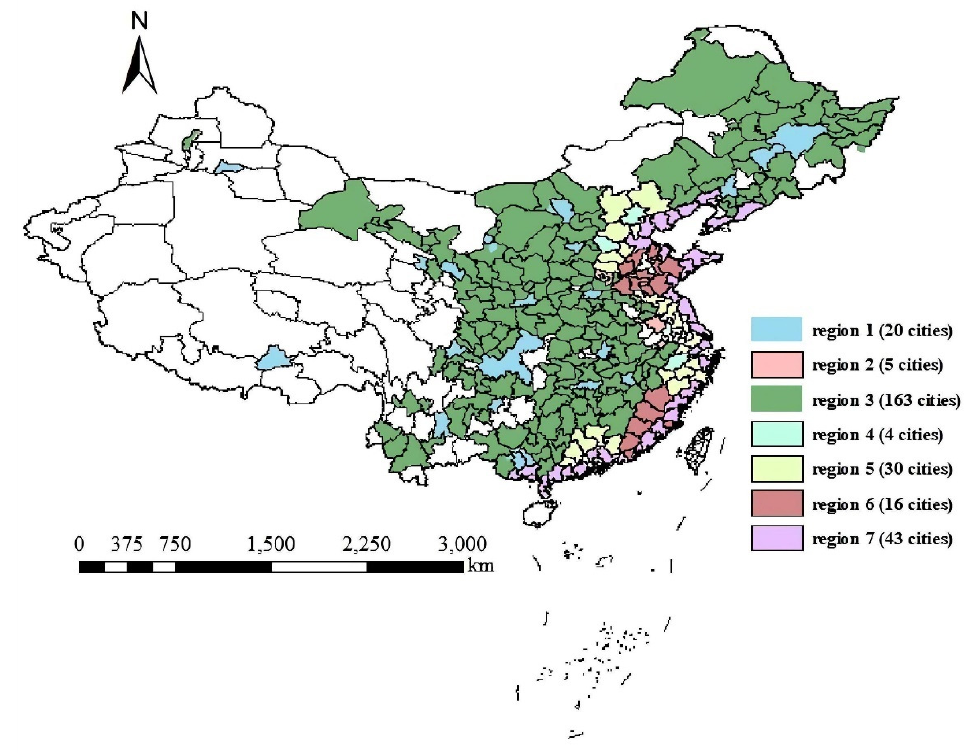
Figure 4. Differentiated urban air pollution governance area in China.